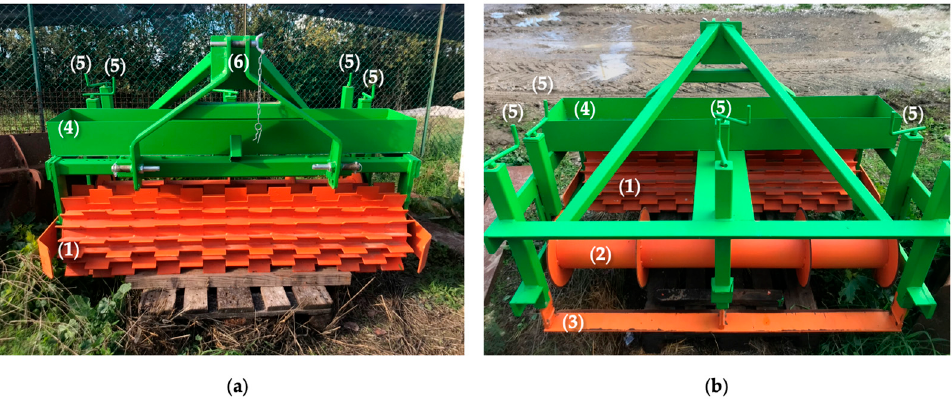
cutting discs; ( 3 ) undercutting blade; ( 4 ) hopper; ( 5 ) telescopic servo rudders; ( 6 ) three-point